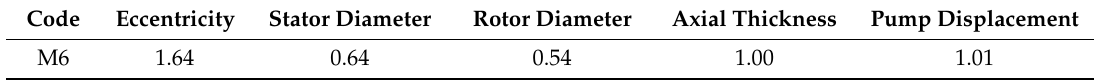
Figure 17. Rotating assembly of the unit M6, contrasted with the configurations M0 and M3. From the results listed in Table 7, it is evident that at equal axial thickness (M6 vs M0) the reduction of the rotor diameter improves the filling, while at equal diameter of the rotor (M6 vs M3),